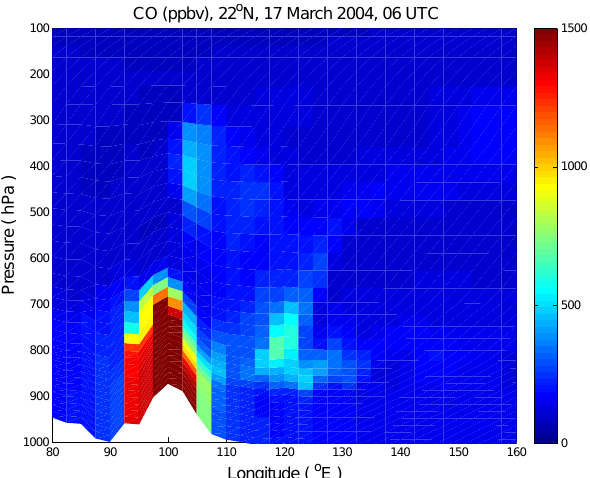
Figure 12. A longitude–altitude cross section of CO along 22 ◦ N on 17 March 2004 at 06:00 UTC, simulated by GEOS-Chem. The topography of the Hengduan Mountains is indicated in